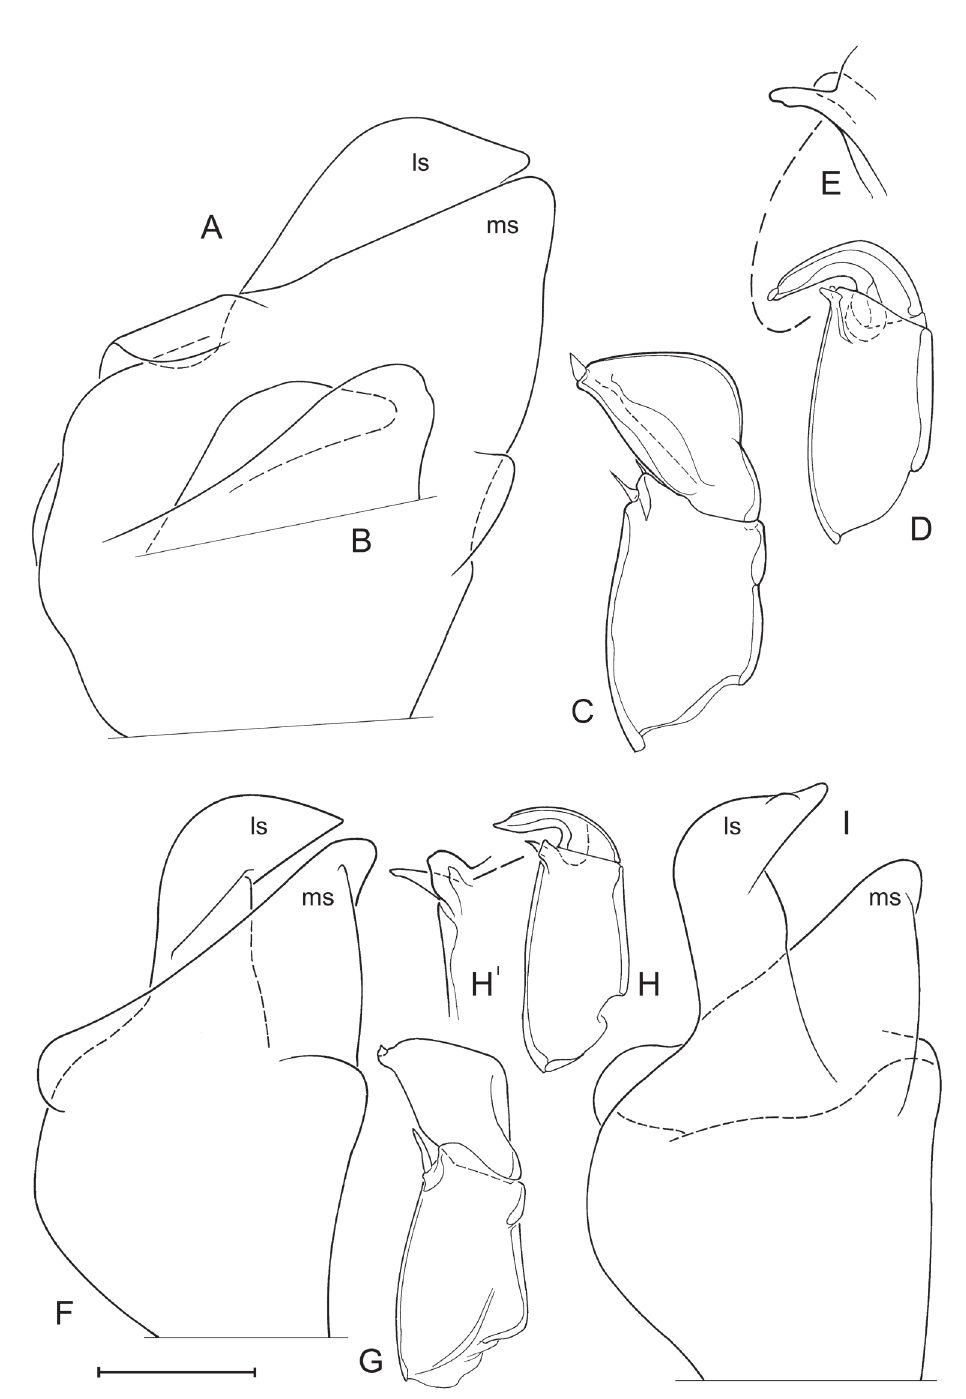
Fig. 13. Bennelongia gnamma sp. nov. (a-e, type specimens from type locality, cairn rock, Ostr012a) and Bennelongia hirsuta sp. nov. (F-I type specimens from type locality, styles rock, Ostr012D). Males. — A-E . B. gnamma sp. nov.: A . Hemipenis (both hemipenes symmetrical in this specimen, WaMc52264). B . apical part of hemipenis (WaMc52265). C . right prehensile palp (WaMc52264). D . left prehensile palp (WaMc52264). E . Idem, detail of ventro-apical part of first segment (different specimen, WaMc52265). — F-I . B. hirsuta sp. nov. (WaMc52271): F . Hemipenis. G . right prehensile palp. H . left prehensile palp. H’ . Idem, detail of ventro-apical part of first segment. I . Hemipenis. scale: a-D, F-I = 92 µm; e, H’ = 37